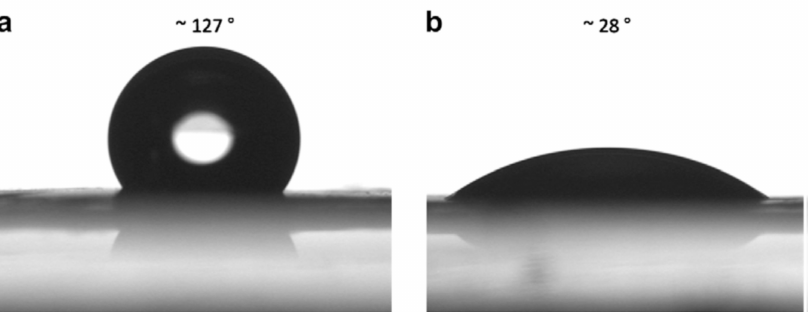
Figure 9. Water contact angles for oxidized ( a ) and untreated ( b ) electrospun PES membranes. Provided with permission from Elsevier [34].